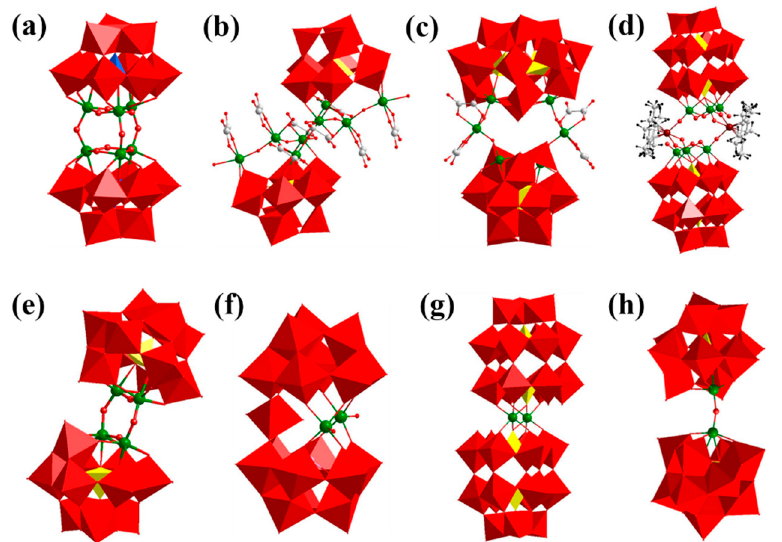
Figure 3. The ball ‐ and ‐ stick and polyhedral illustration of ( a ) [A ‐ β ‐ Si 2 W 18 Ti 6 O 77 ] 14 − polyoxoanion, ( b ) [Ti 8 (C 2 O 4 ) 8 P 2 W 18 O 76 (H 2 O) 4 ] 18 − polyoxoanion, ( c ) [Ti 6 (C 2 O 4 ) 4 P 4 W 32 O 124 ] 20 − polyoxoanion, ( d ) P 2 W 15 Ti 3 O 60 (OH) 2 } 2 (Cp*Rh) 2 ] 16 − polyoxoanion; ( e ) [ α , α ‐ P 2 W 20 Ti 4 O 78 ] 10 − polyoxoanion; ( f ) [Ti 2 (OH) 2 As 2 W 19 O 67 (H 2 O)] 8 − polyoxoanion; ( g ) [Ti 2 {P 2 W 15 O 54 (OH 2 ) 2 } 2 ] 8 − polyoxoanion and ( h ) [(Ti 2 O)(PW 11 O 39 ) 2 ] 8 − polyoxoanion. Color codes: WO 6 , red; PO 4 , yellow; SiO 4 , light blue; Ti, green; As, lavender; C, gray; O, red; H, black.